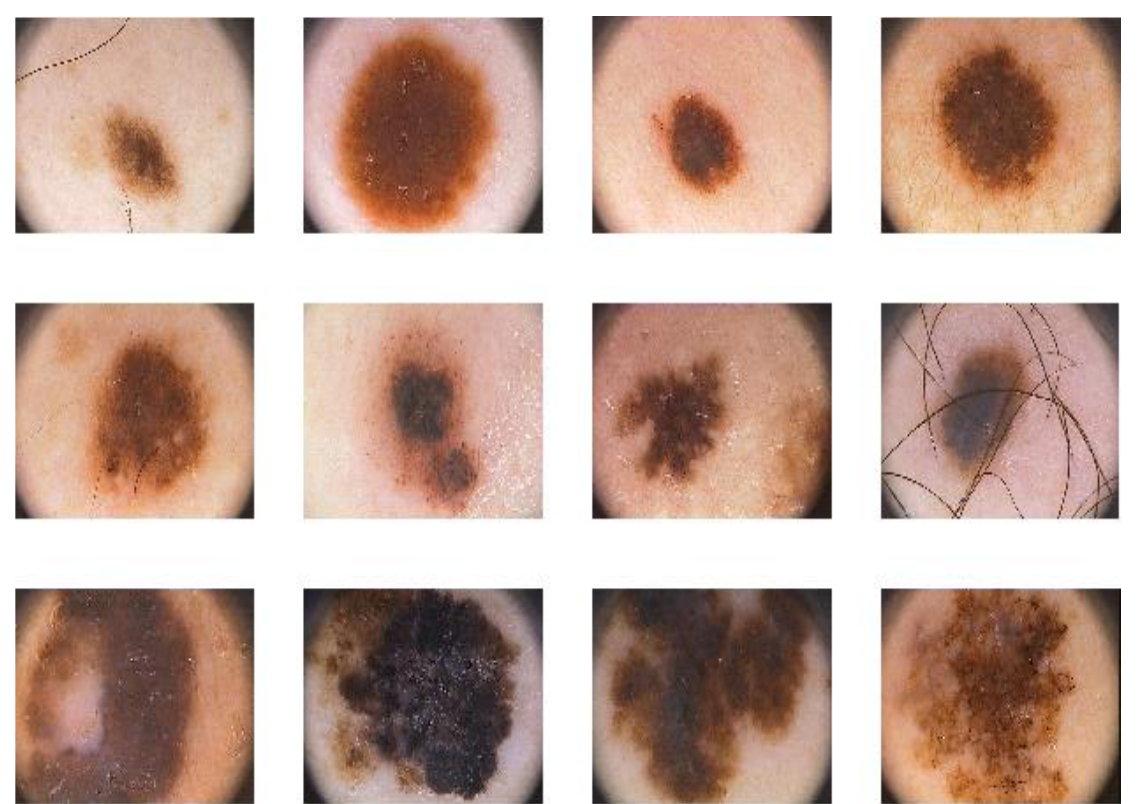
Figure 9. A sample of images from the PH2 dermoscopic dataset: common nevi (row 1), atypical nevi (row 2) and melanomas (row